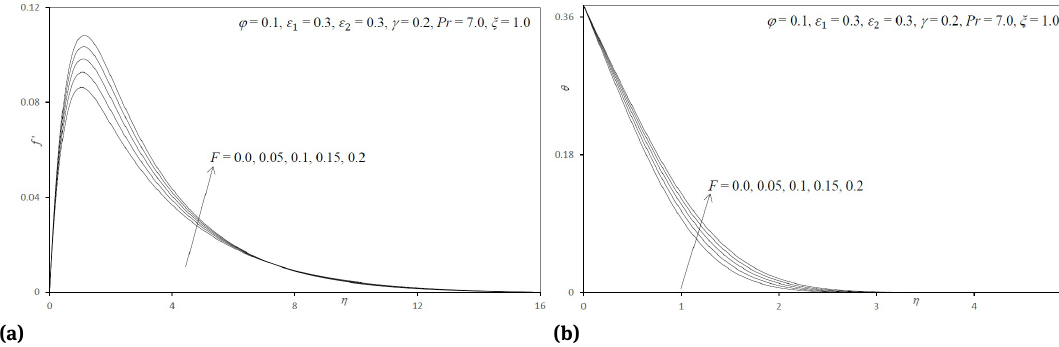
Fig. 7: (a) Effect of F on Velocity Profiles; (b) Effect of F on Temperature Profiles